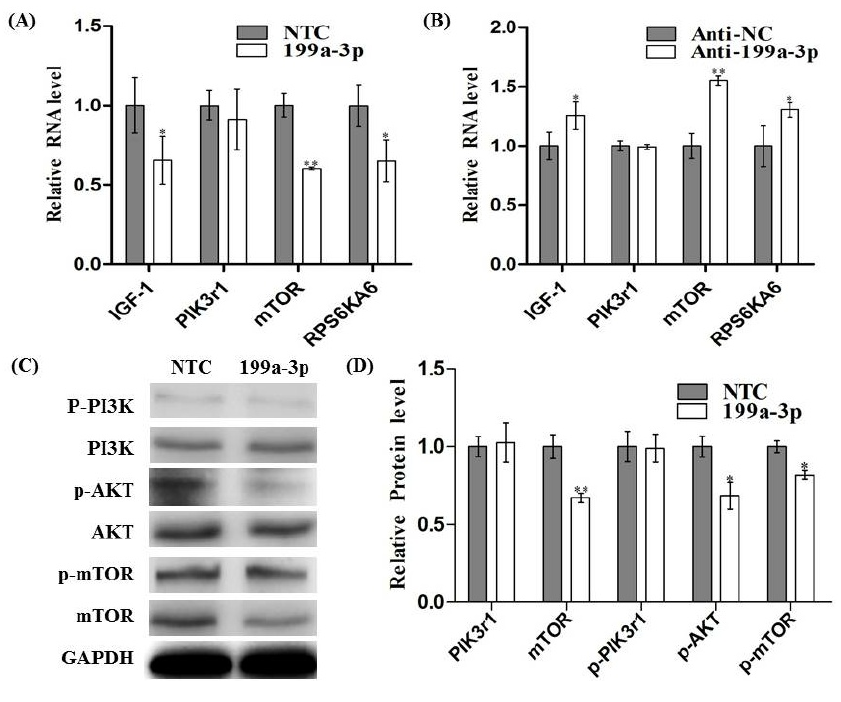
Figure 5. MiR-199a-3p regulated the IGF/AKT/mTOR pathway in C2C12 cells. ( A ) The mRNA expression of miR-199a-3p targeted genes, IGF-1, PIK3r1, mTOR, RPS6KA6, were detected by real-time PCR in C2C12 cells after transfection of miR-199a-3p mimic or negative control miRNA; ( B ) Real-time PCR detected IGF-1, PIK3r1, mTOR and RPS6KA6 mRNA expression after transfection of miR-199a-3p inhibitor or negative control into C2C12 cells; ( C ) Several signal molecules of IGF/AKT/mTOR signal pathway, including PIK3r1 (p85), p-PIK3r1 (p-p85), AKT, p-AKT, mTOR, p-mTOR were detected by Western Blot after transfection of miR-199a-3p mimic or negative control miRNA; and ( D ) protein expression levels were quantitated using image J. Results are presented as mean ± S.E.M. n = 3. * p < 0.05. ** p < 0.01